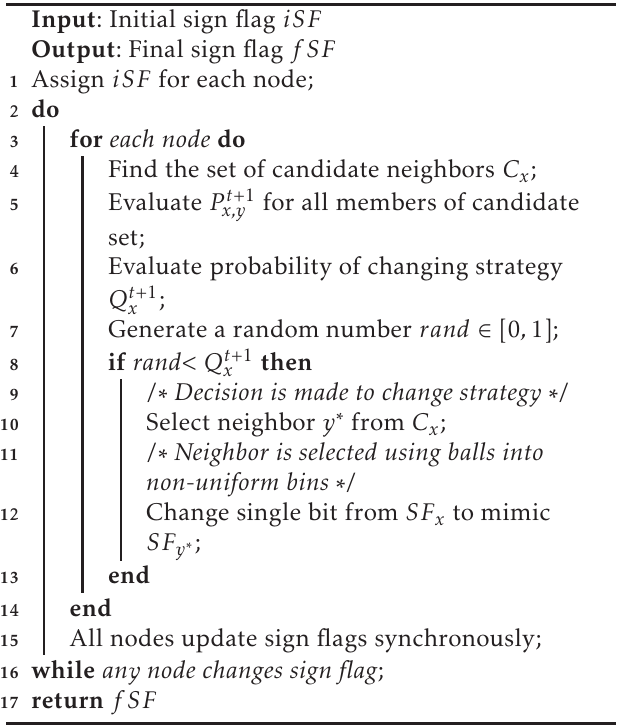
Algorithm 1: Algorithm for updating profile attribute sign